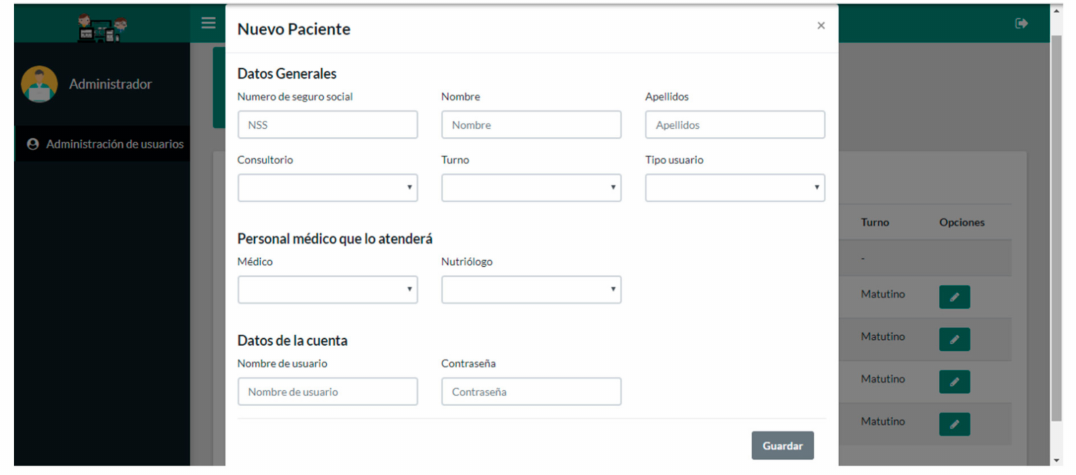
Figure 10. Administrator user interface: Service to add a user with a medical or nutritionist role.